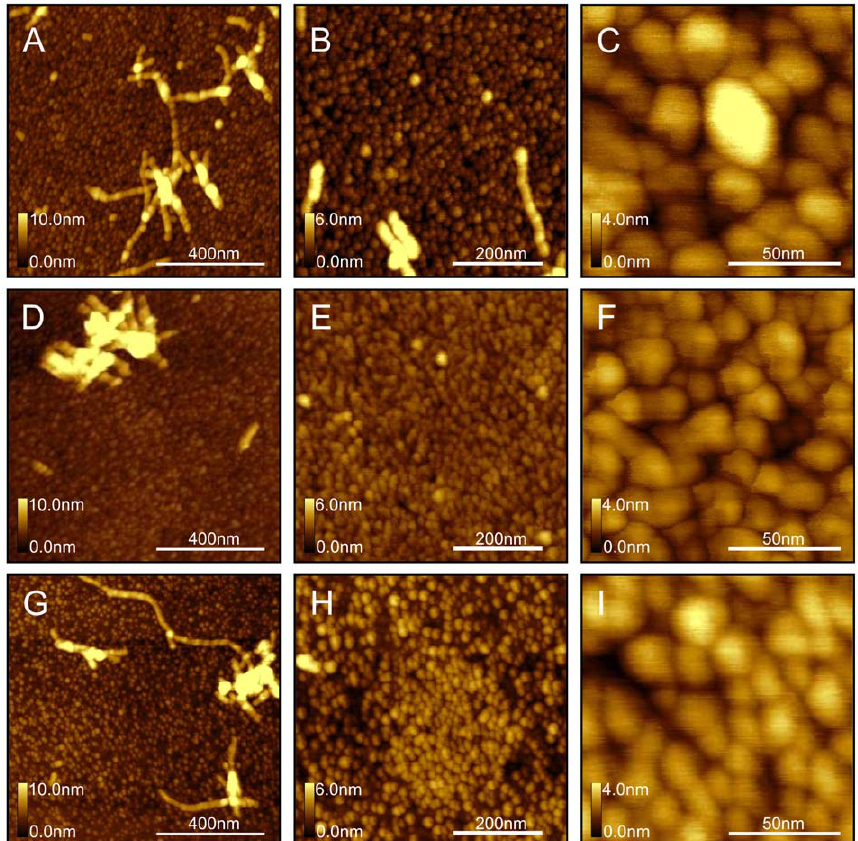
Figure 3. High resolution images of AFM topography of Aß aggregates formed on modified surfaces: CH 3 - (A–C), COOH- (D – F), and NH 2 - (G–I) modified surfaces, after incubation with A b (1–42) solution (500 m g/ml) for 1 hour at 37 6 C.